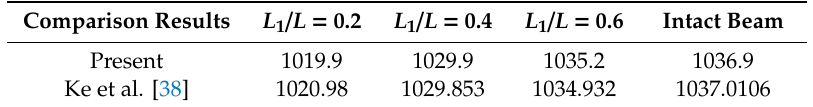
Table 1. Comparison of fundamental frequency for a cracked isotropic homogenous clamped-free (C-F) beam.